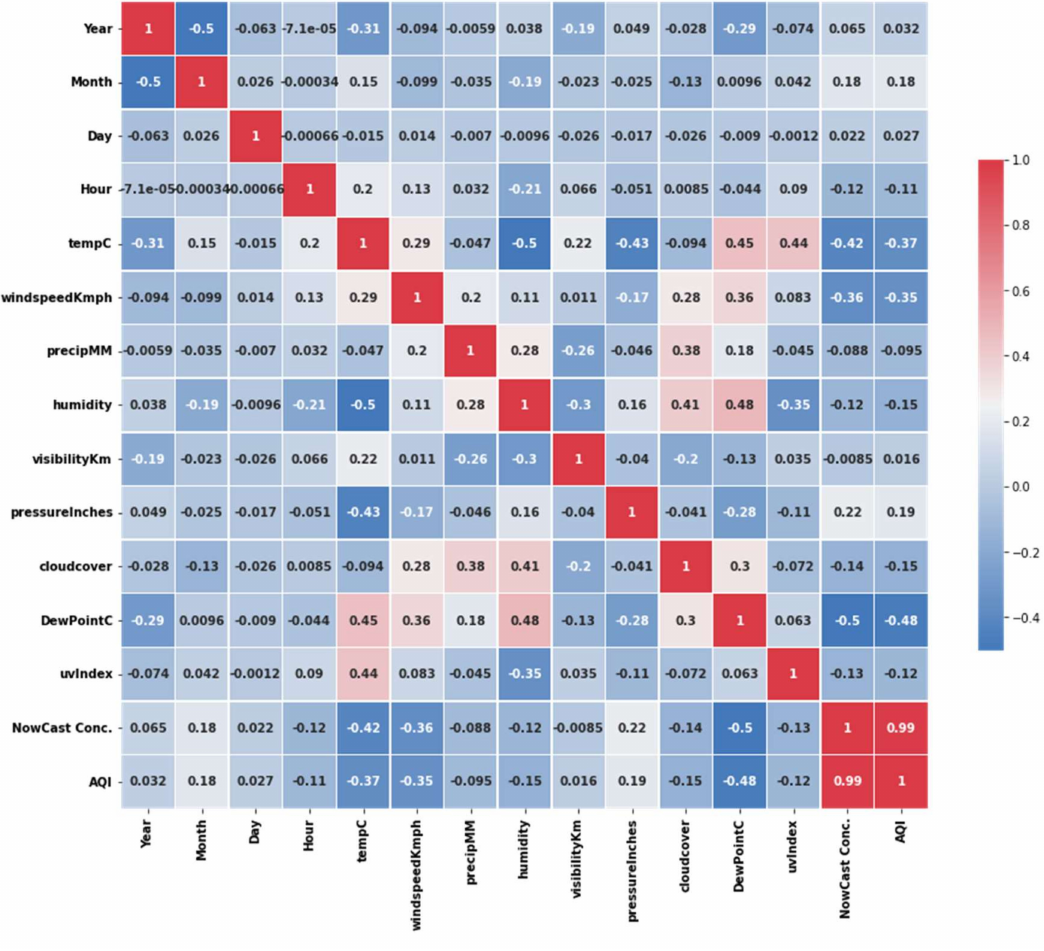
Figure 7. Correlation heat map for